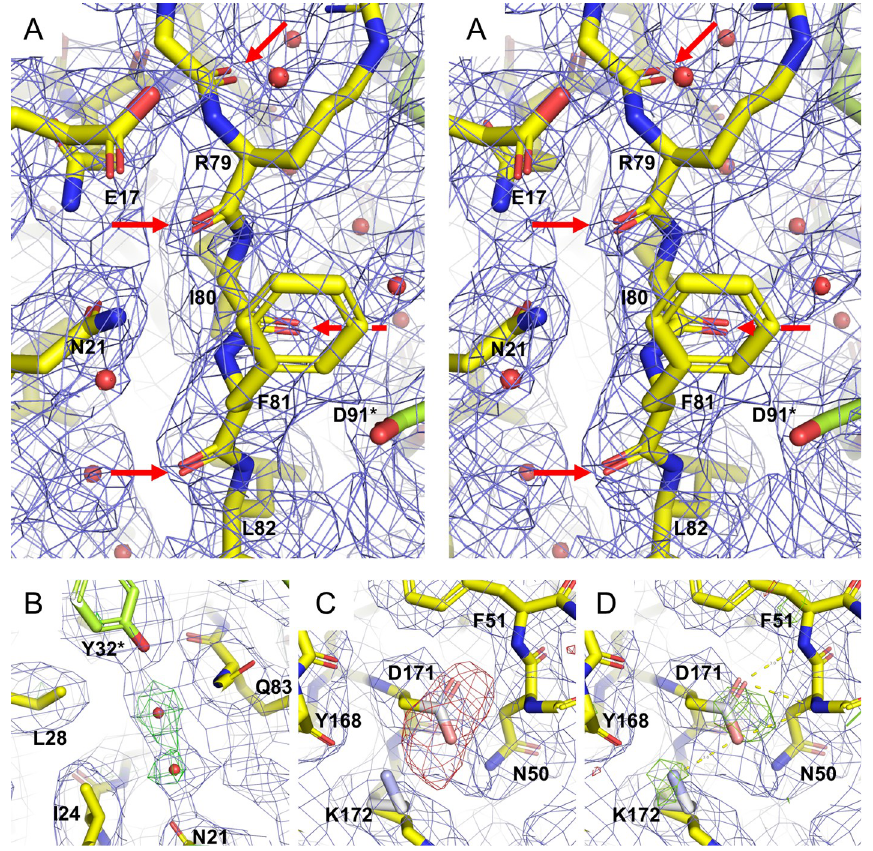
Fig 2. Representative densities during quasi-crystallographic refinement against the cryo-EM Coulomb potential map. (A) Stereo view demonstrating cryo-EM Coulomb potential map density (blue cage) for carbonyl oxygens (red arrows) in accordance with a nominal resolution of 2.7 Å . The final refined model (PDB code 6SHT) is shown as yellow sticks, with octahedrally symmetry related residues colored lime. (B) Positive difference electron density (F map - F calc ), green, contoured at 2.5 σ ) after first round of quasi-crystallographic refinement of manually fitted apoferritin monomer superimposed with the final model (yellow / lime sticks). As the initial refinement was based on protein residues alone, the difference density clearly demonstrates the presence of two solvent molecules, also present in the cryo-EM map. These water molecules are also present in the crystal structure (PDB code 3WNW). (C) The initial refinement also exhibited negative difference density (red cage, contoured at -3.5 σ ) for all carboxylate groups (here Asp171). These atoms (Asp: C γ , O δ 1 and O δ 2 : Glu: C δ , O ε 1 and O ε 1 ) were given an occupancy of zero so that they no longer contribute to structure factor calculations (i.e. set dummy, white / pink atoms). For a number of carboxylate groups including Asp171, the next round of refinement revealed positive difference density (D, green cage contoured at 3.5 σ ), demonstrating an influence of these atoms on the cryo-EM Coulomb potential. This round of refinement also revealed density for a second conformation of the Lys172 side chain (white sticks).